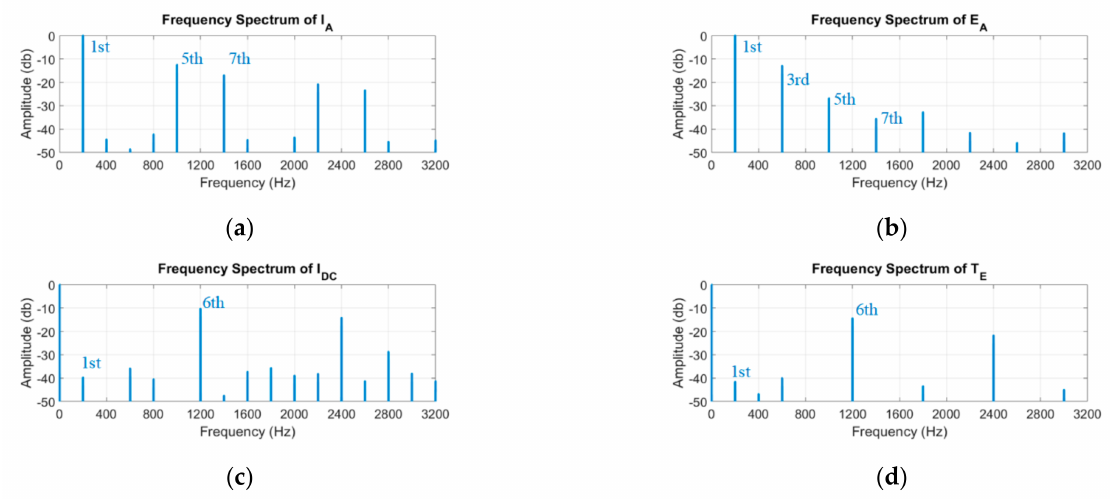
Figure 7. Healthy motor operation at rated speed and load: ( a ) Frequency spectrum of phase A current; ( b ) Frequency spectrum of phase A back-EMF; ( c ) Frequency spectrum of the DC-link current; ( d ) Frequency spectrum of electromag- netic